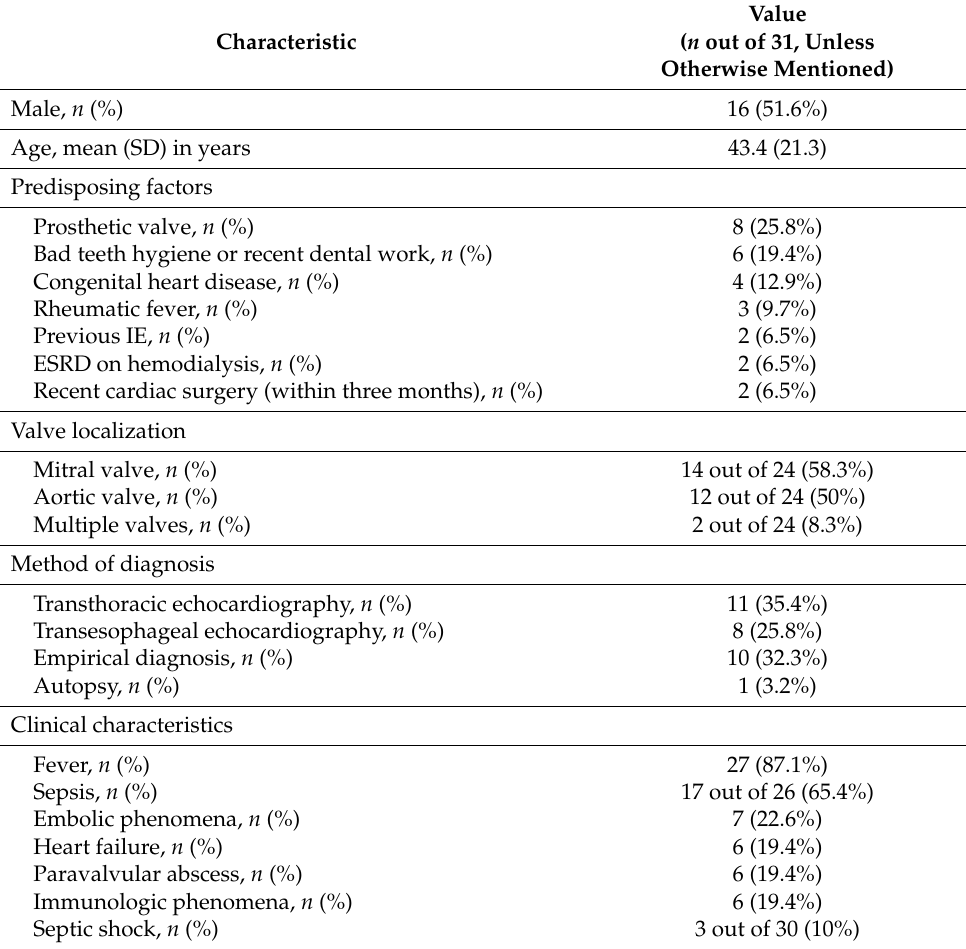
Table 1. Characteristics of 31 patients with Infective Endocarditis by Moraxella spp. Values show cases among patients with available